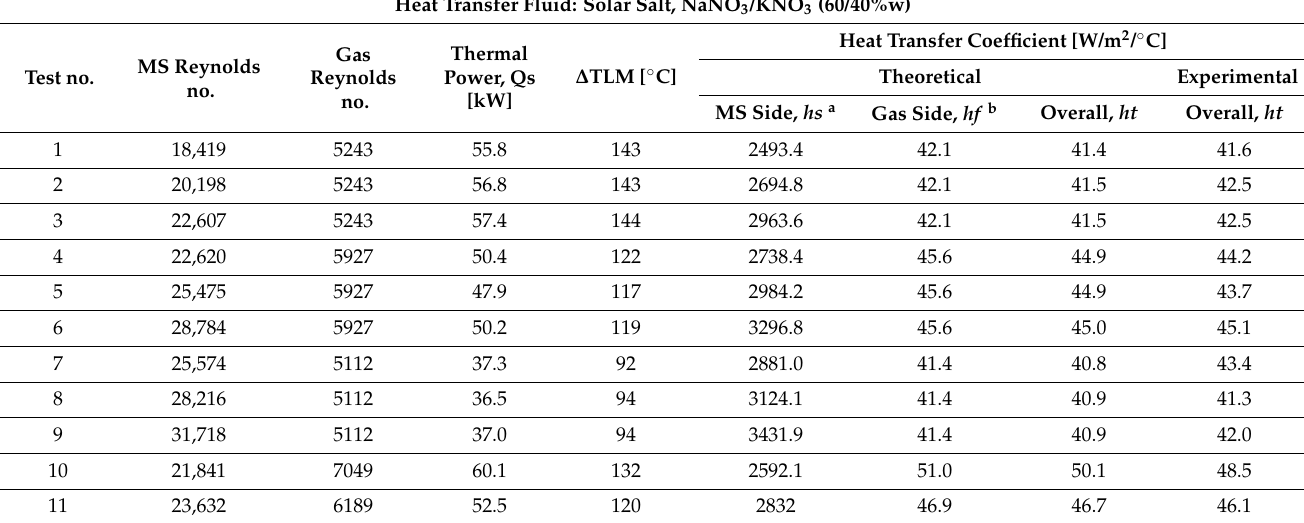
Table 4. Comparison between heat transfer coefficient determined experimentally (MSH prototype) and using relevant correlations: Dittus-Boelter equation (a) and correlations specific for banks of finned tubes [19] (b). All tests were carried out using LPG as gas fuel (except for test no.11 when a biogas-like mixture was used) and the solar salt as HTF. Energies 2021 , 14 , x FOR PEER REVIEW 14 of 18 Heat Transfer Fluid: Solar Salt, NaNO 3 /KNO 3 (60/40%w) Test no. difference between theoretical and experimental values is usually <± 3% (only in test no. 7 the difference is about 6%) showing the consistency of experimental data with the heat transfer correlations.